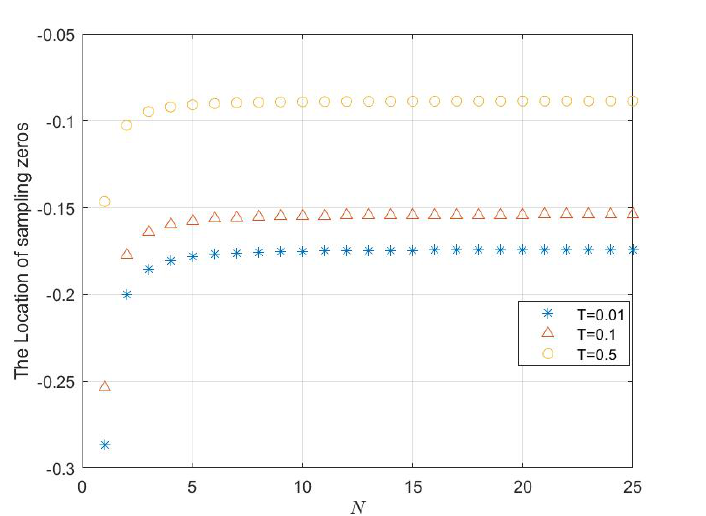
Figure 5. The different asymptotic properties of the sampling zero of a sampled-data model with different fixed T and not fixed N when AFTSH is used with f =